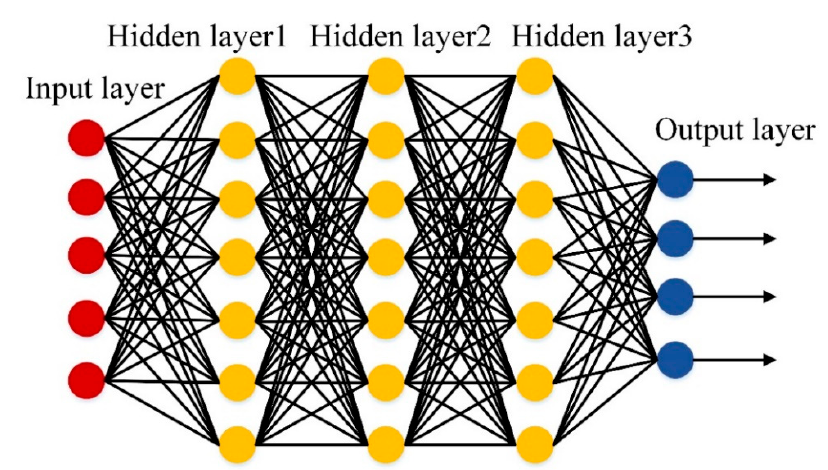
Figure 5. Structure of the deep neural network.